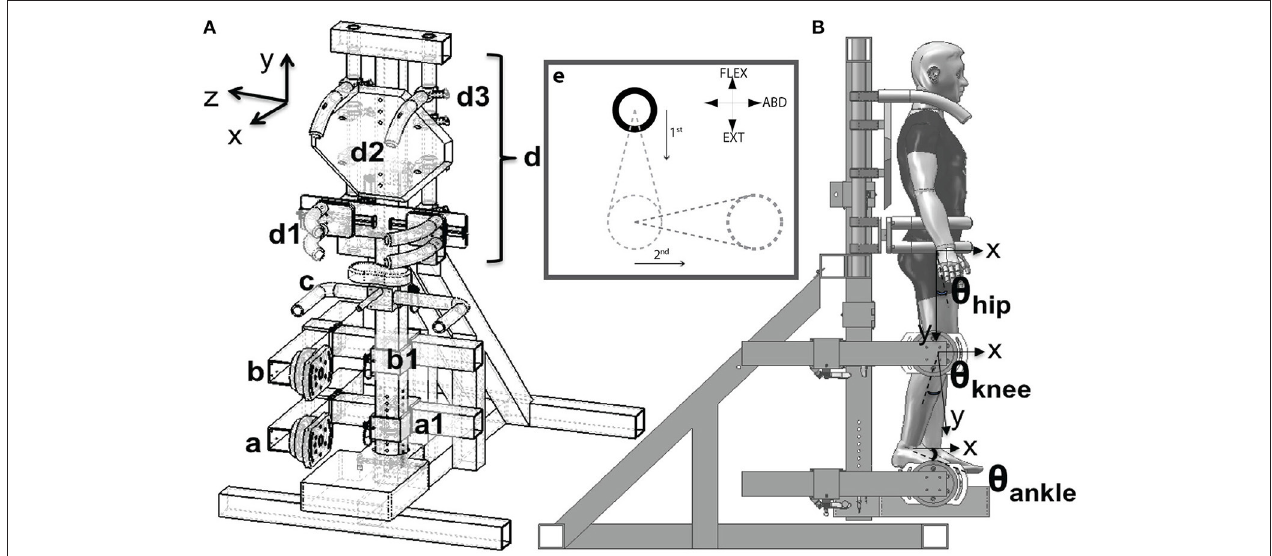
FIGURE 1 | Schematic of the experimental setup. (Aa,b) Adjustable foot and thigh placement system and JR3 6DoF sensors. (c) Handle bars for accessing the setup. (d) Upper body positioning system. (d1) Hip clamping mechanism. (d2) Back plate. Harness not shown. (d3) Shoulder clamps. (e) . Visual display. The cursor (solid circle) could move across the entire plane. The dashed circles and lines indicate the target torque and target trajectory. Participants were requested to first match the vertical distance by generating the corresponding hip flexion/extension or ankle plantarflexion torque. Then, while maintaining the vertical position constant, participants were asked to generate the abduction torque necessary to match the horizontal displacement. The hip abduction torque was then quantified as that generated while the vertical level was constant. The display was adjusted for left/right extremities and flexion/extension torques accordingly such that upward displacement indicated flexion and downward extension, displacement to the left was left hip abduction and vice versa for the right extremity. (B) Angle descriptions, sagittal plane. The hip flexion angle was measured with respect to the projection of the trunk’s gravity vector. The knee flexion angle was measured with respect to the thigh. The ankle angle was measured with respect to the shank. The hip abduction angle (frontal plane), was measured with respect to the gravity vector’s